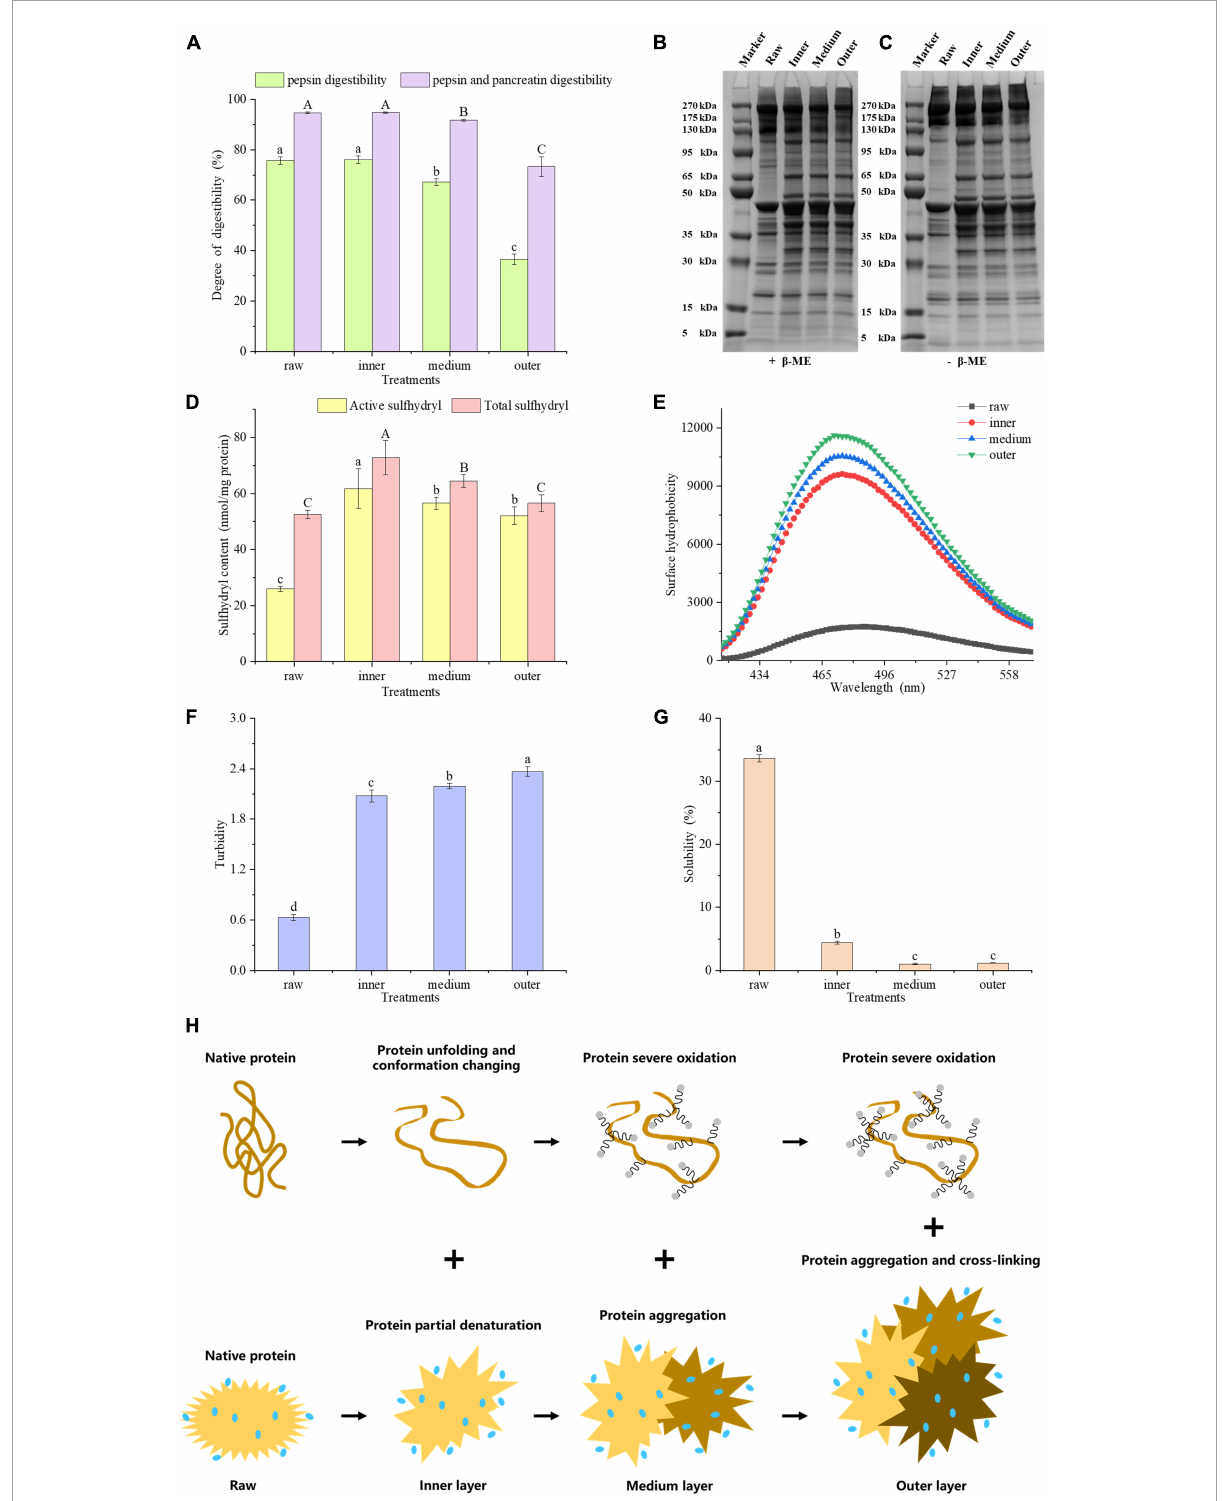
FIGURE2 (A) Gastric and gastrointestinal digestibility of pork proteins from different layers. SDS-PAGE patterns of reduced (B) and unreduced (C) proteins. (D) Sulfhydryl content, (E) surface hydrophobicity, (F) turbidity, (G) solubility of MP samples in different layers. (H) Mechanistic diagram of MP conformation and aggregation changes of different layers. Letters A, B, C or a–d indicate significant differences in measured variables among different treatments ( P <